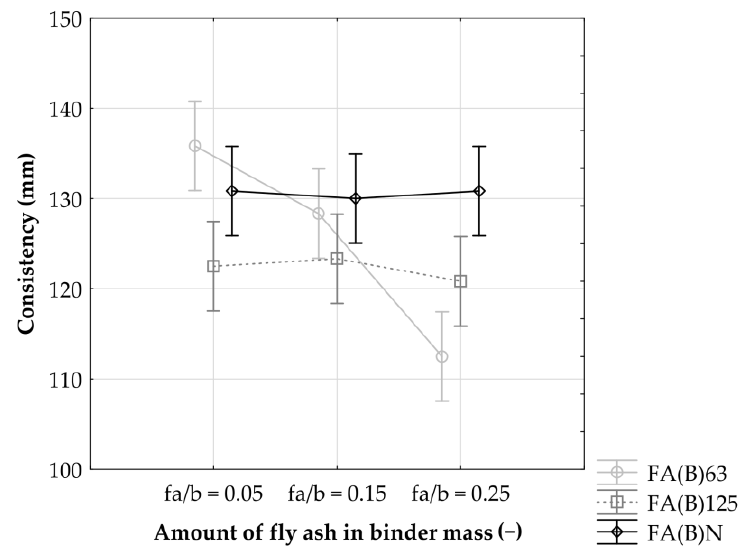
Figure 5. Fresh consistency test results of mortars with addition of sieved fly ash FA(B)63 and FA(B)125 compared with the results of mortars with untreated fly ash FA(B)N (ANOVA 95% CI in the whiskers).